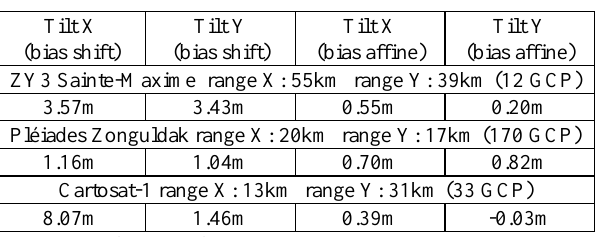
Table 7. Influence of model tilt over covered range determined